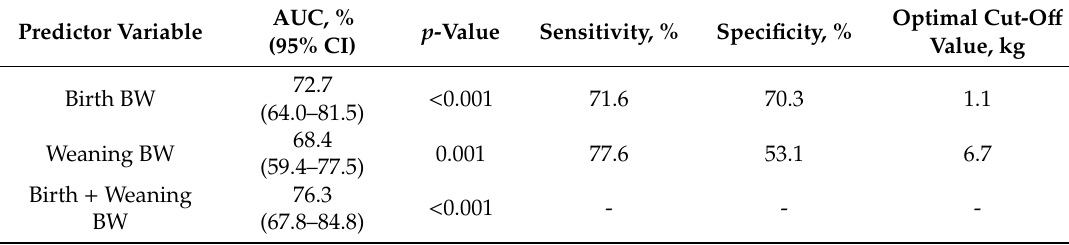
Table 4. Performance [Area under the curve (AUC) and 95% confidence interval (CI)], p -value, sensitivity and specificity for the optimal cut-off value to identify pigs that would reach target slaughter weight [i.e., 110 kg of body weight (BW)] at 22 weeks of age considering birth BW, weaning BW and birth BW + weaning BW as predictor variables.